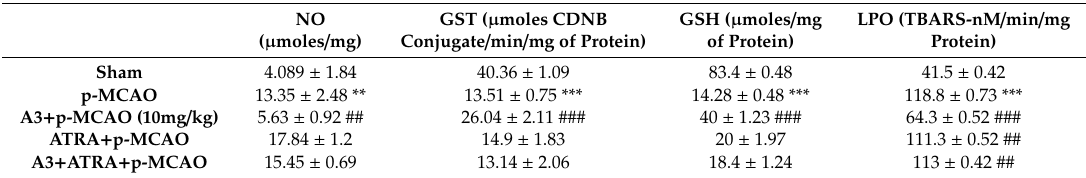
Table 1. E ff ect of A3 on oxidative